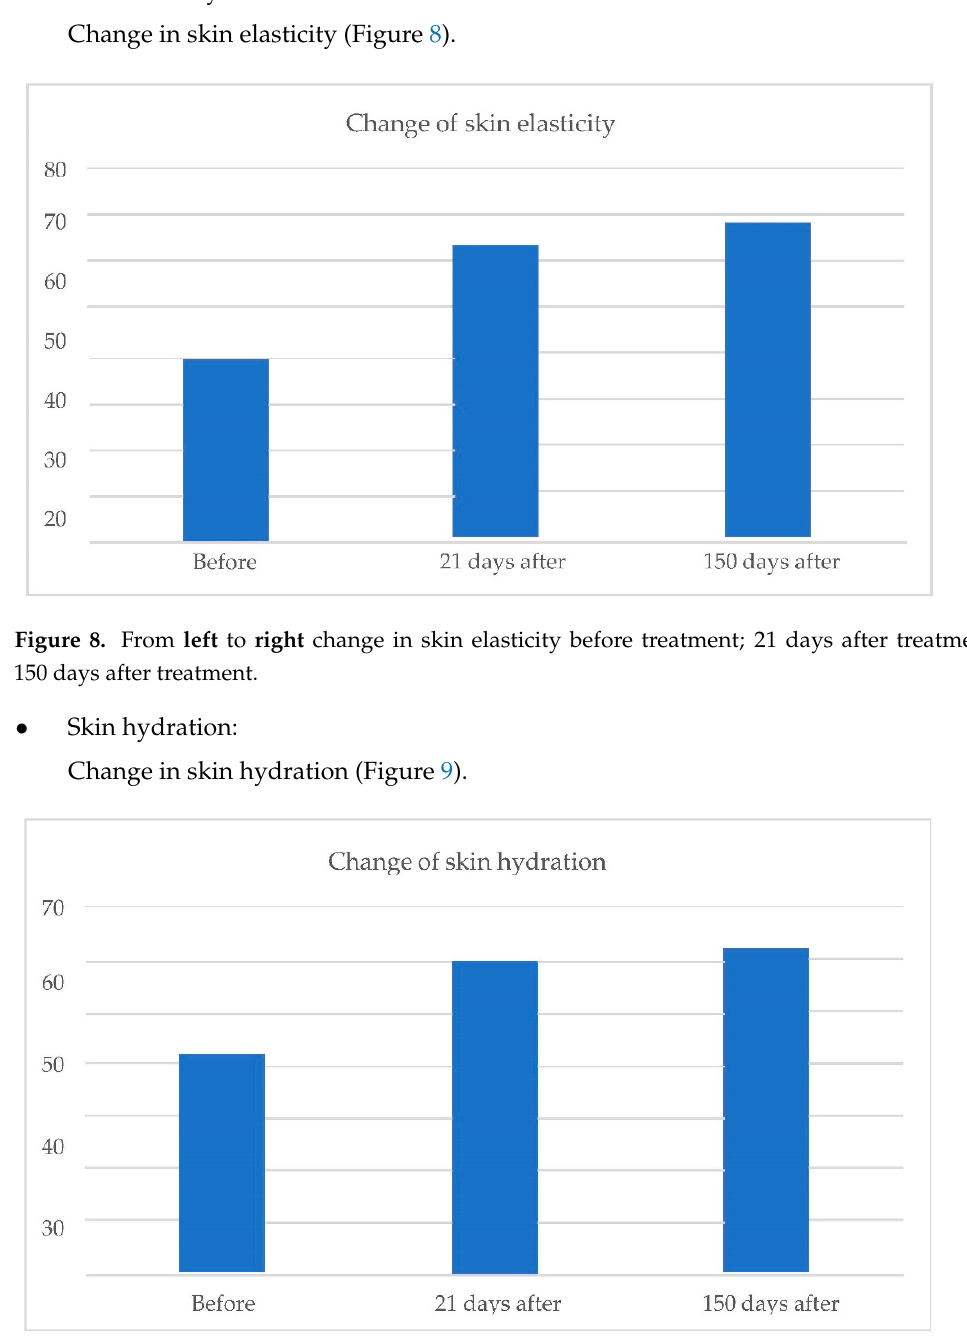
Figure 9. From left to right change in skin hydration before treatment; 21 days after treatment; 150 days after treatment.